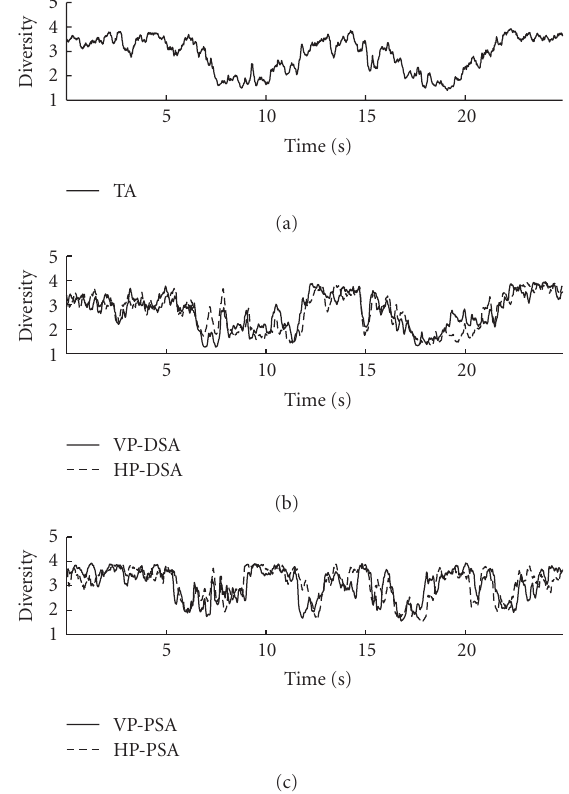
Figure 13: Diversity measure of the channels at each array on Kent